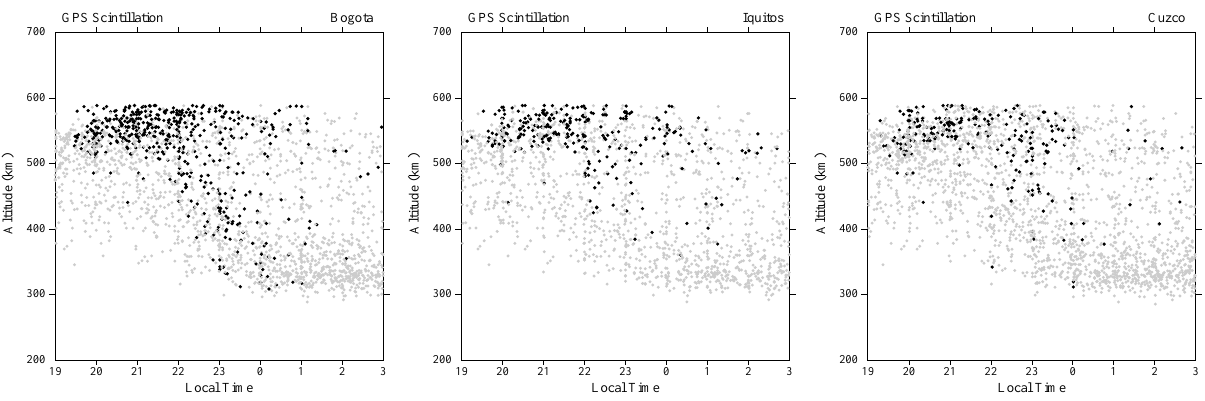
Fig. 10. hm F2 value of the equatorial ionosphere during the ten-month observational period presented in this study. The gray dots correspond to events when the GPS scintillation index was below 0.20. The black dots are for S4 levels above